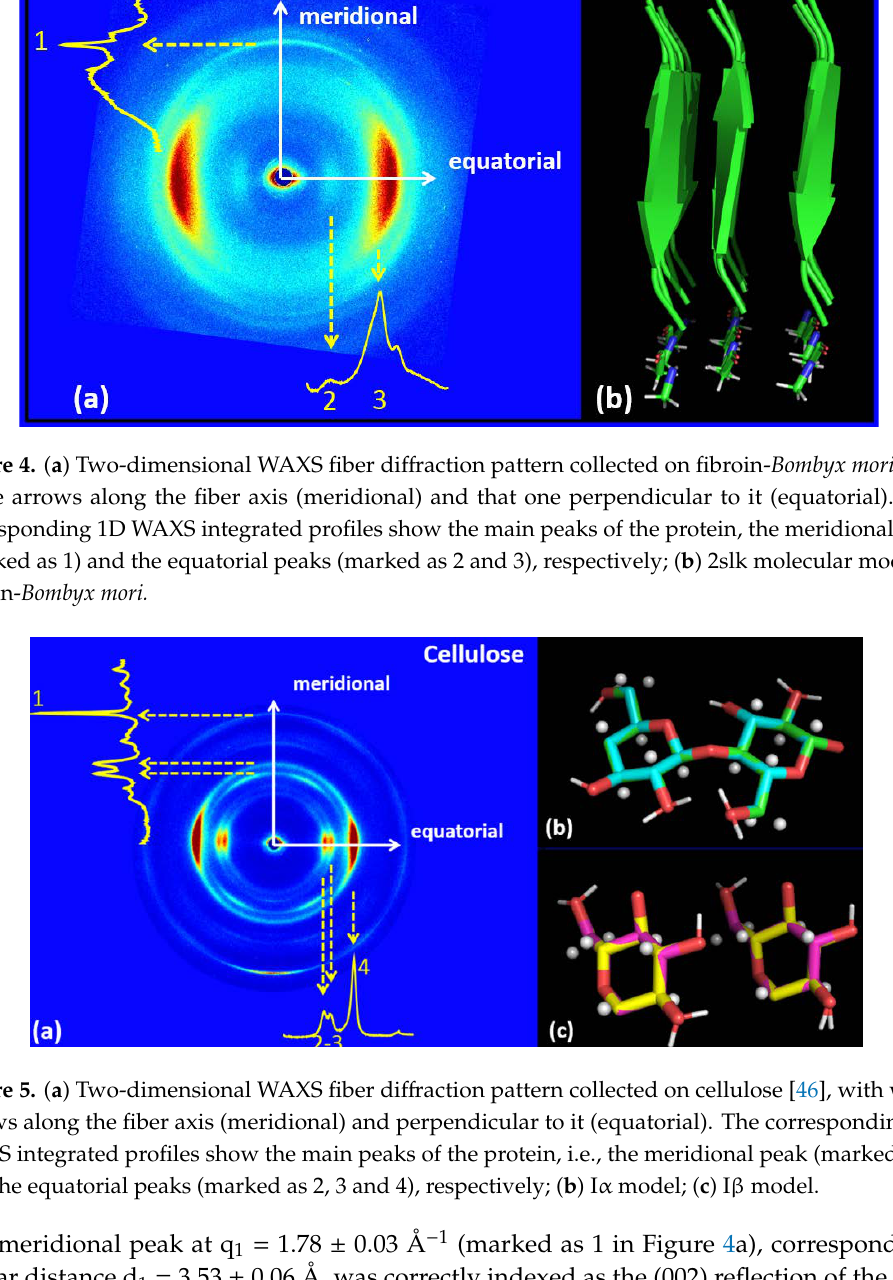
Table 1. Positions and relative interplanar distances extracted from the 1D-WAXS data reported in Figures 3 (TYPE 1 COLLAGEN), 4 (FIBROIN− BOMBYX MORI) and 5 (CELLULOSE). TYPE 1 COLLAGEN